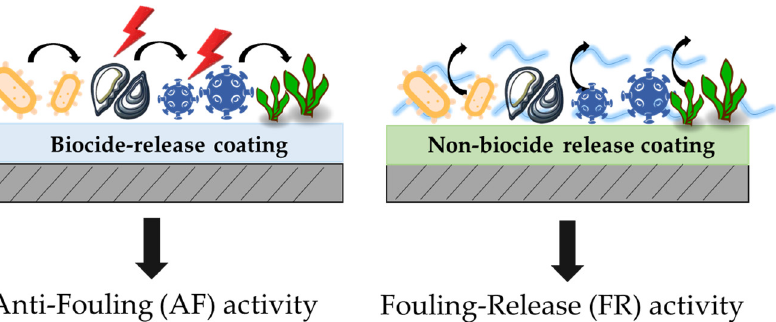
Figure 1. Schematization of anti-fouling and fouling release activity of sol–gel functional